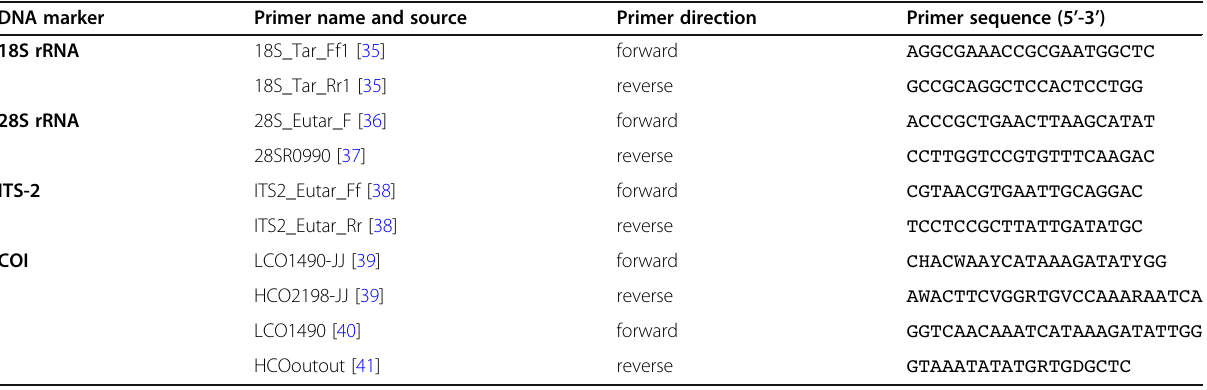
Table 2 Primers with their original references used for amplification of the four DNA fragments sequenced in the study. The primer set LCO1490-JJ + HCO2198-JJ was used for COI amplification in four populations (FI. 066, IT. 337, PL. 015, US. 057), whereas LCO1490 + HCOoutout was used for one population